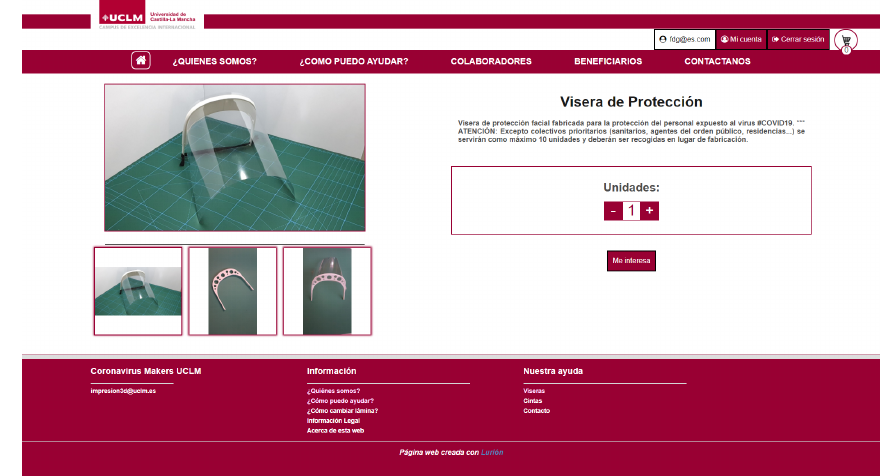
Figure 7. PPE request (type and quantity of units) in the web information